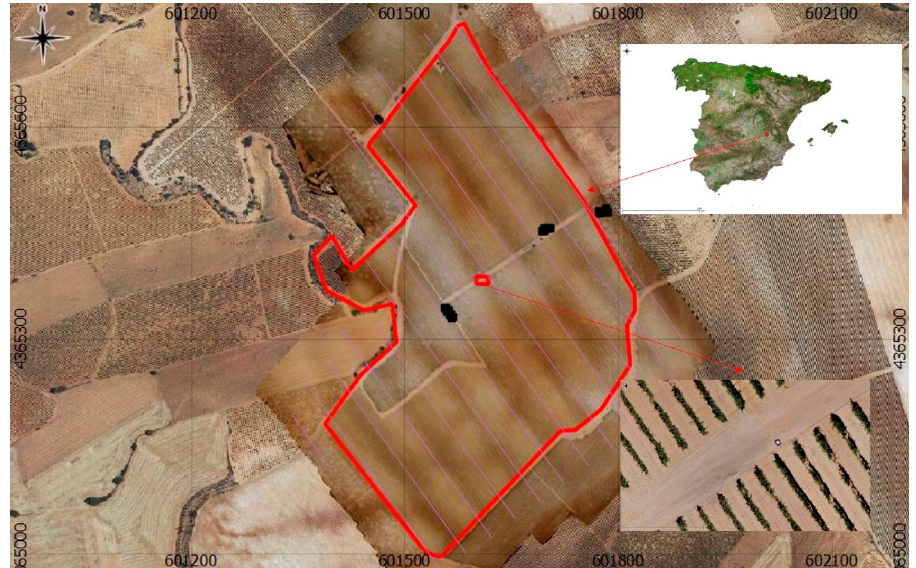
Figure 5. Location of the case study, and detail of the orthoimage obtained with the UAV. Black squares are ground measurements of validation points (PNOA, 2015).